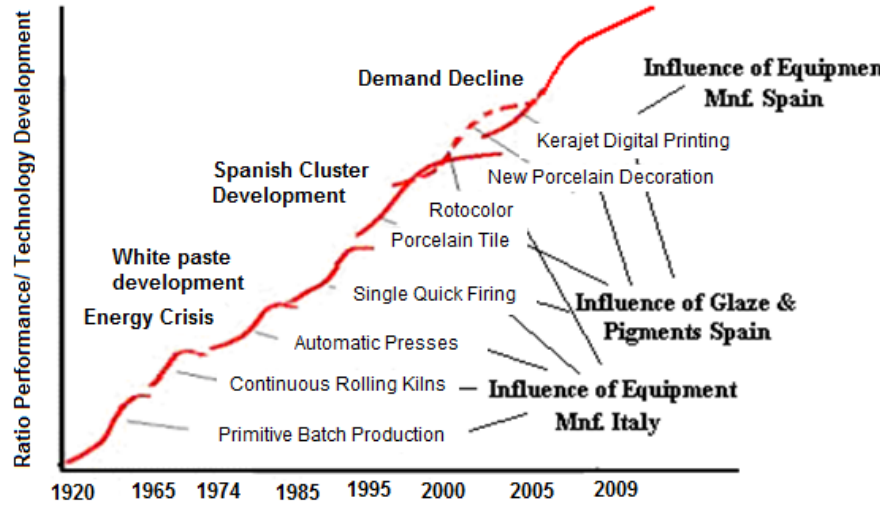
Figure 6. Technology discontinuity curves for the ceramic tile industry